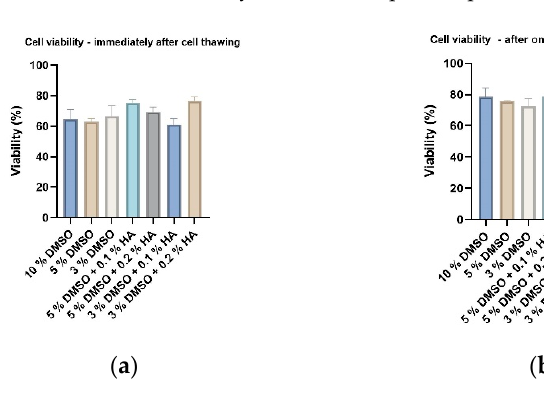
Figure 12. Total ADSCs count measured using CaSy cell counter (OMNI Life Science GmbH): ( a ) immediately after thawing; ( b ) after one week of cell cultivation; ( c ) after two weeks of cell cultivation. Data are presented as a mean and SD plotted as error bars. The statistical significances (* p < 0.05) were determined between control and experimental groups using Friedman’s test followed by Dunn’s multiple comparison test.